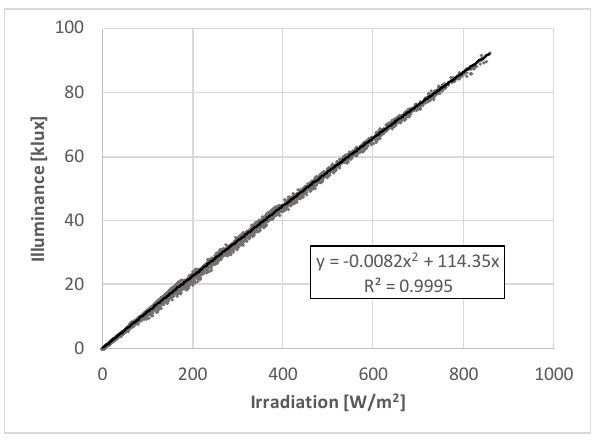
Figure 4. Correlation between external horizontal illuminance and global solar irradiation.